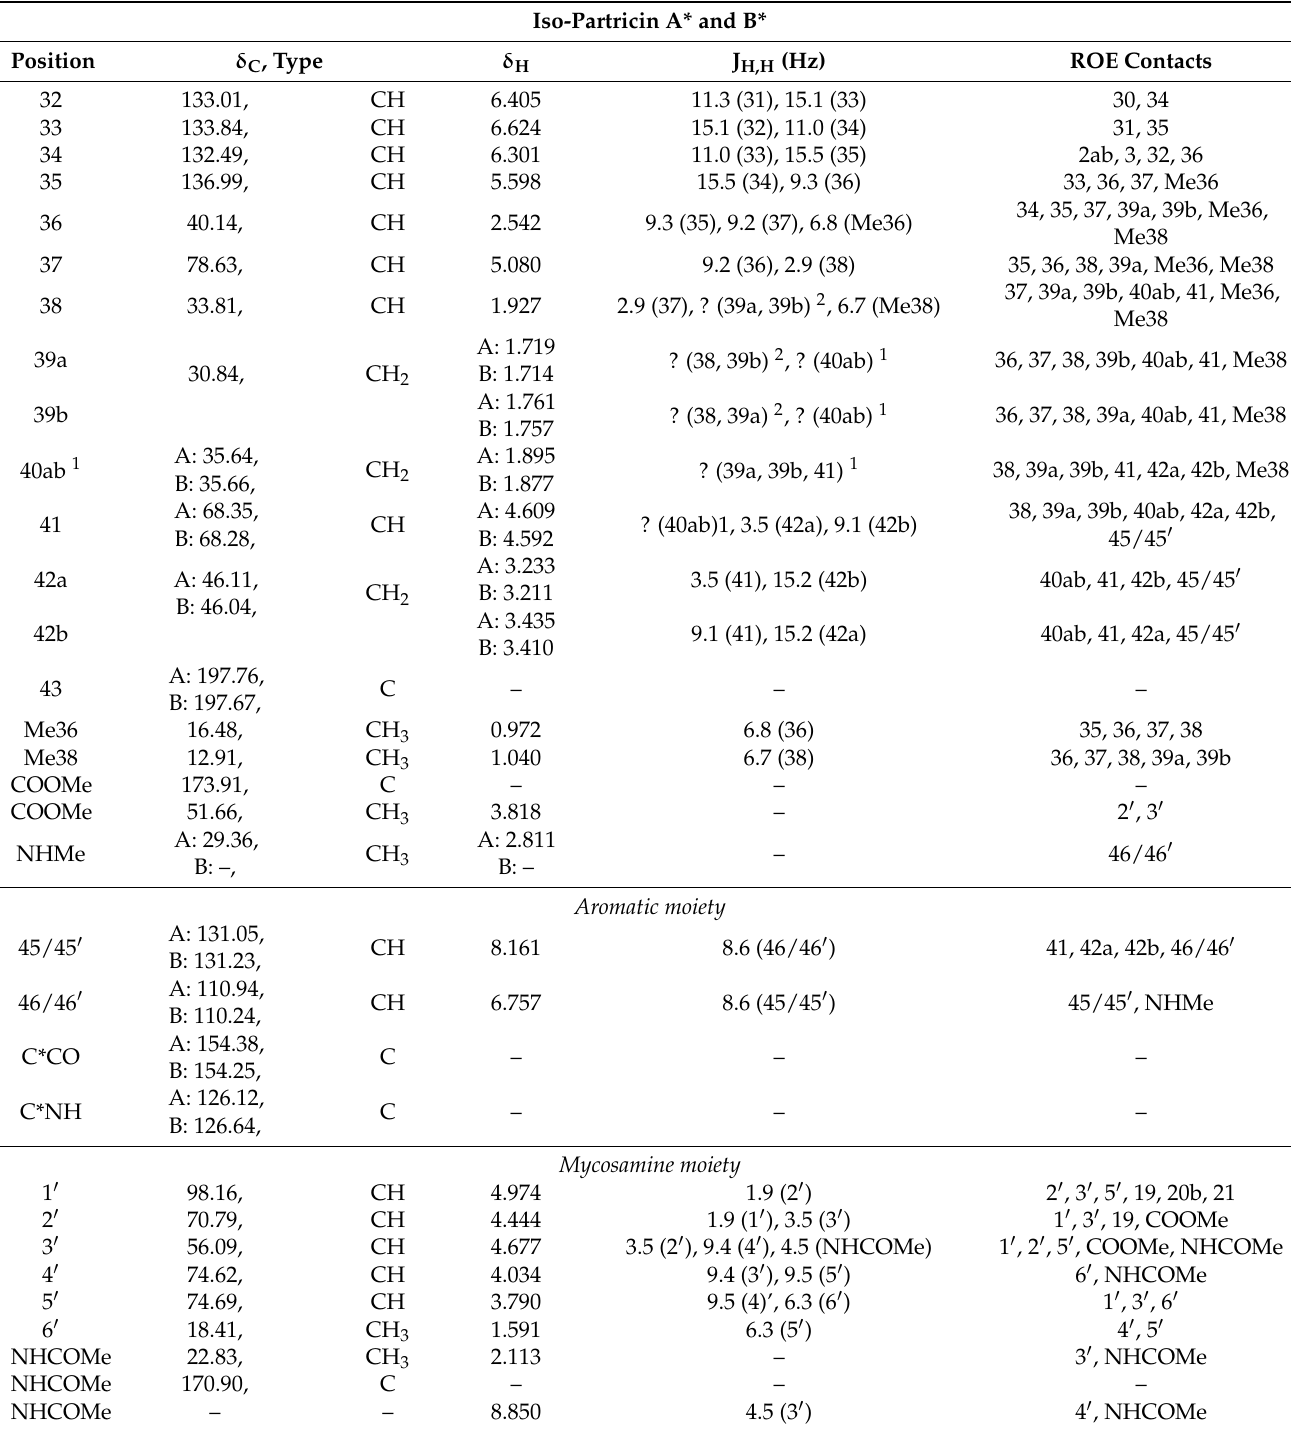
Table A1. Cont . Iso-Partricin A* and